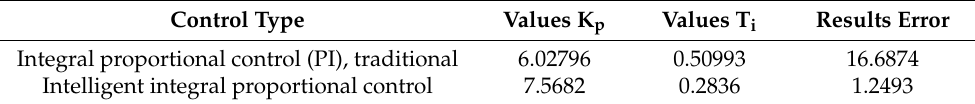
Table 3. Comparison using PI traditional and intelligent PI control.